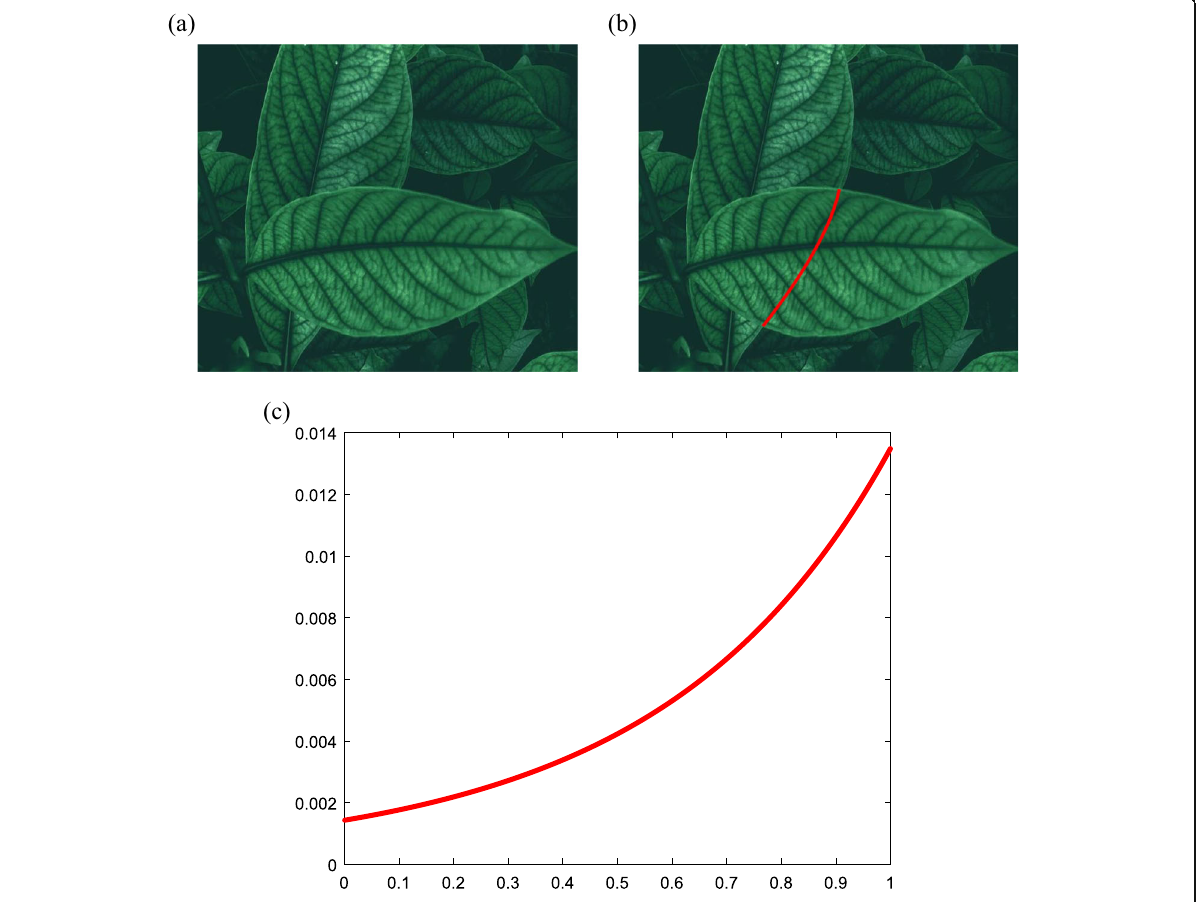
Fig. 13 Occluded leaf edge completion. a : Two overlapping leaves; b : Typical curve; c : Curvature